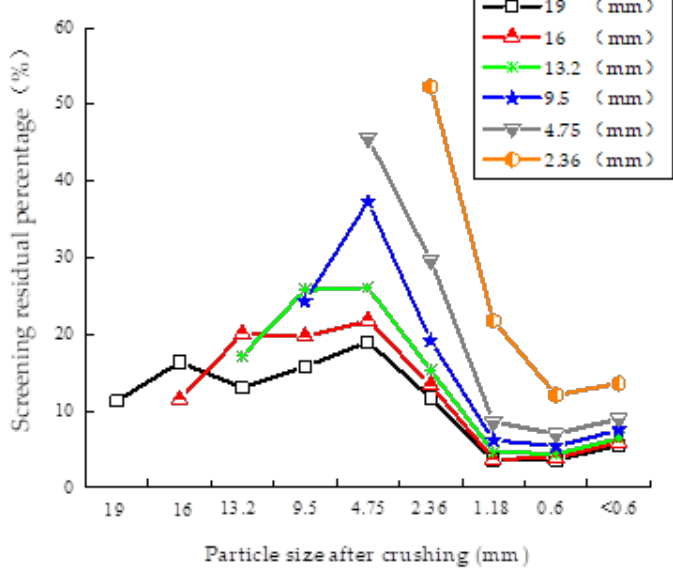
Figure 2. Particle size distribution after crushing each particle size.